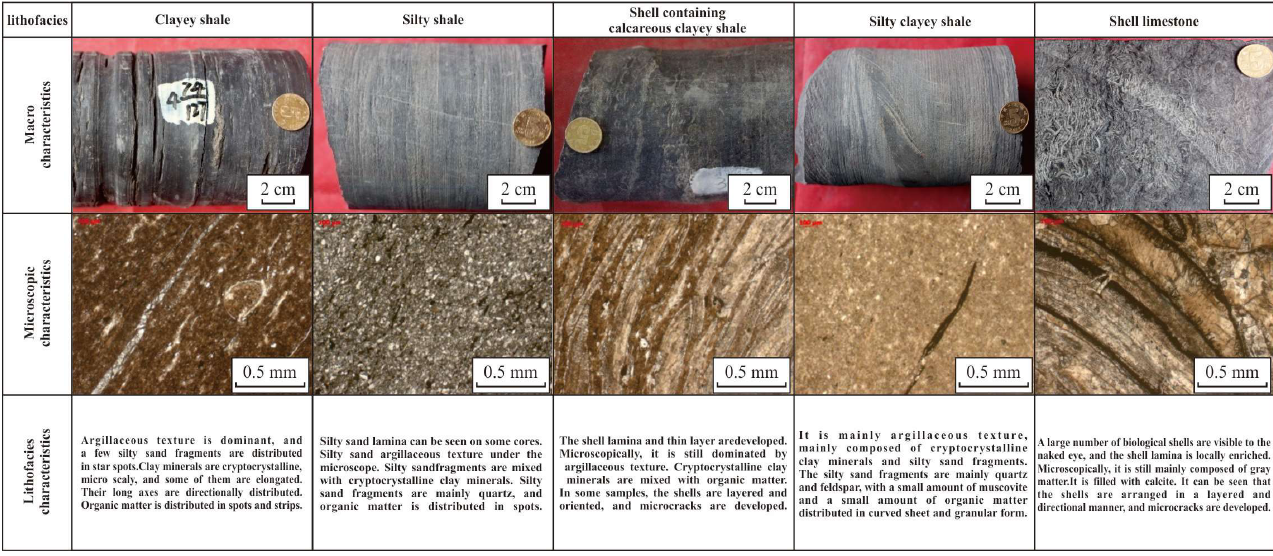
Figure 3. Main lithofacies types of shale in the Da’anzhai Member.